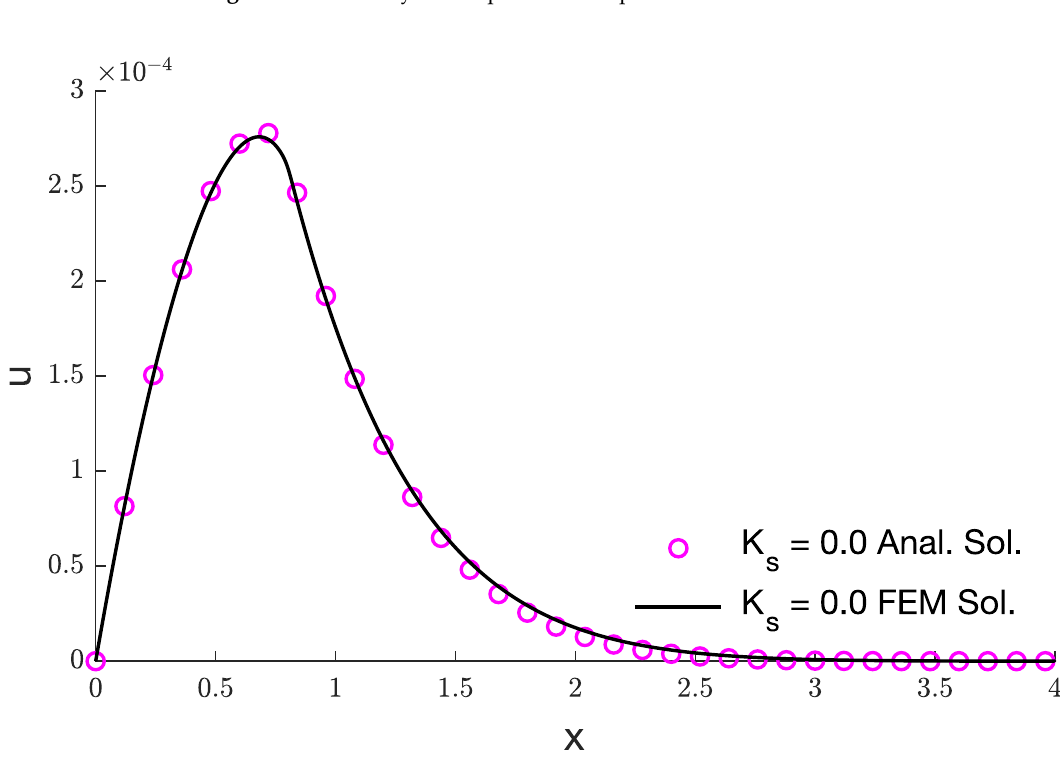
Figure 14. The study on displacement comparison.